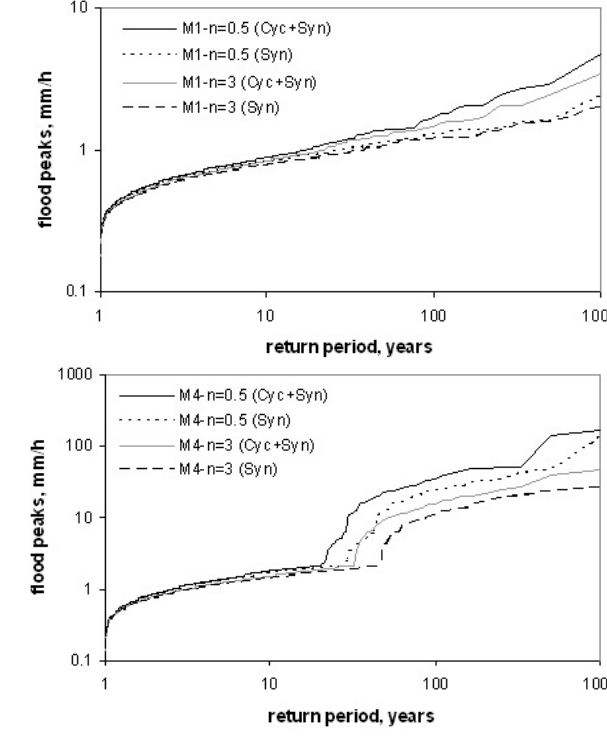
Fig. 10. Flood frequency curves for (a) surface runoff and (b) sub- surface flow generated by synoptic events only (Syn) and synoptic and cyclonic events (Cyc+Syn) using Model 4 with S b =150mm and η =0.5.